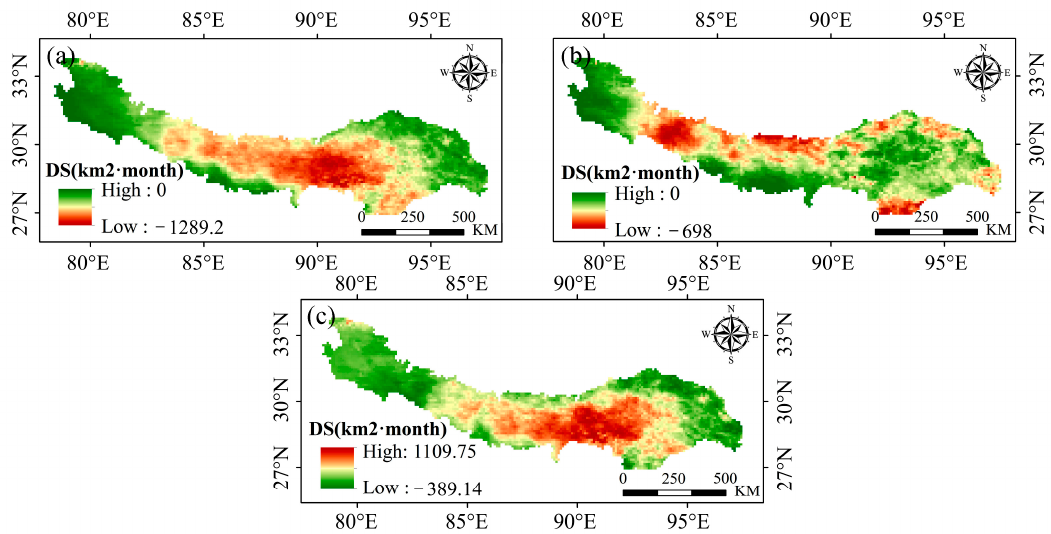
Figure 6. The spatial patterns of drought severity in 1982 ( a ) and 1987 ( b ) as well as the di ff erence between them ( c